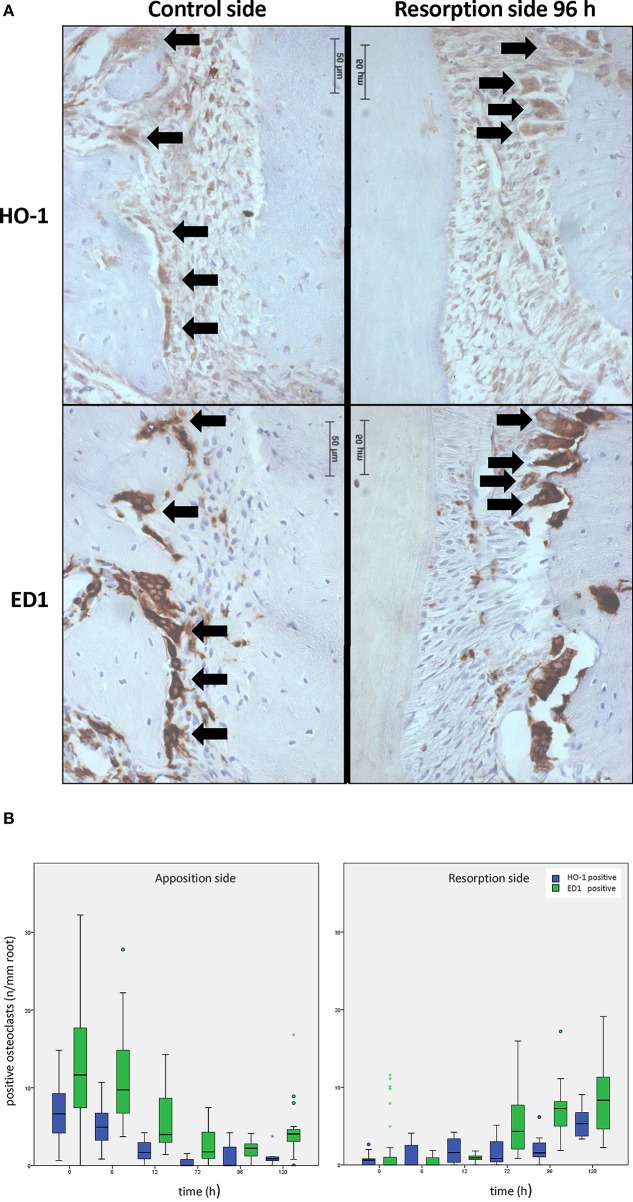
Effects of orthodontic force on HO-1 and ED1 positive osteoclasts. (A) HO-1 (upper lane) and ED1 (lower lane) positive osteoclasts are found both before [control group, distal side (left panel)] and after [experimental group 96 h, resorption side (right panel)] force application as shown by immunohistochemistry. (magnification: x400, black arrows indicating an HO-1 and ED1 positive osteoclast, cells that were multinuclear and located at the alveolar bone outline were marked as osteoclasts). (B) When no force is present osteoclasts are mainly present at the distal site. Upon mechanical stress, ED1 or HO-1 positive osteoclast numbers decrease at the distal side, what is now called the apposition side (left panel), whereas the amount of osteoclasts at the resorption side increase (right panel). HO-1 expression levels in the osteoclasts and the HO-1/ED1 ratio remain similar following mechanical stress (Independent-Samples T-tests, p > 0.05).